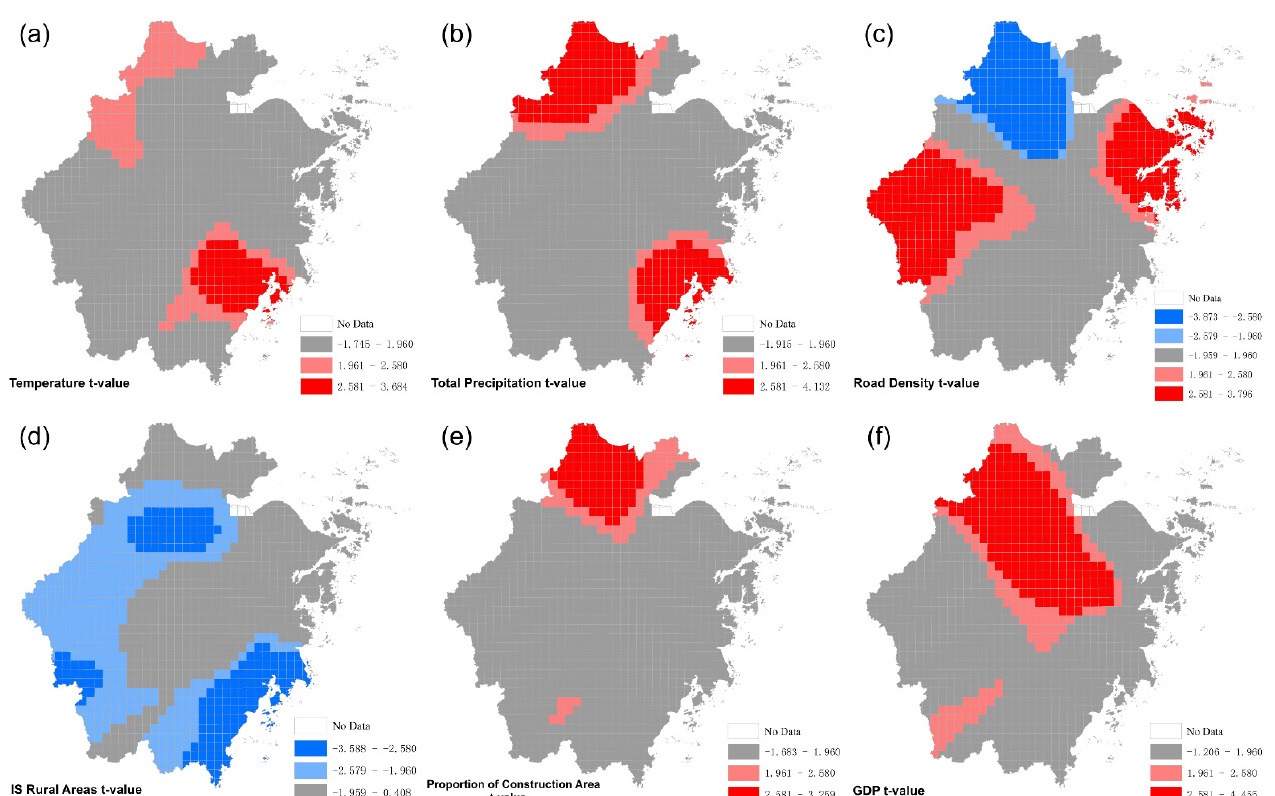
Figure 4. Spatial variation of t-value in geographically weighted logistic regression model, including ( a ) temperature, ( b ) total precipitation, ( c ) road density, ( d ) dummy variable for rural areas, ( e ) proportion of construction area, and ( f ) GDP.